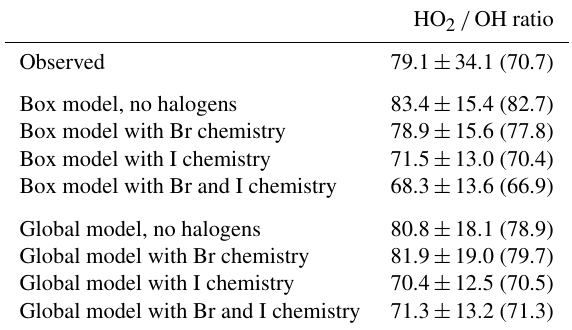
Table 2. Mean ( ± 1 σ ) midday (11:00–13:00LT) ratios of HO 2 to OH (SOS1 and SOS2 combined). Median values are given in paren-